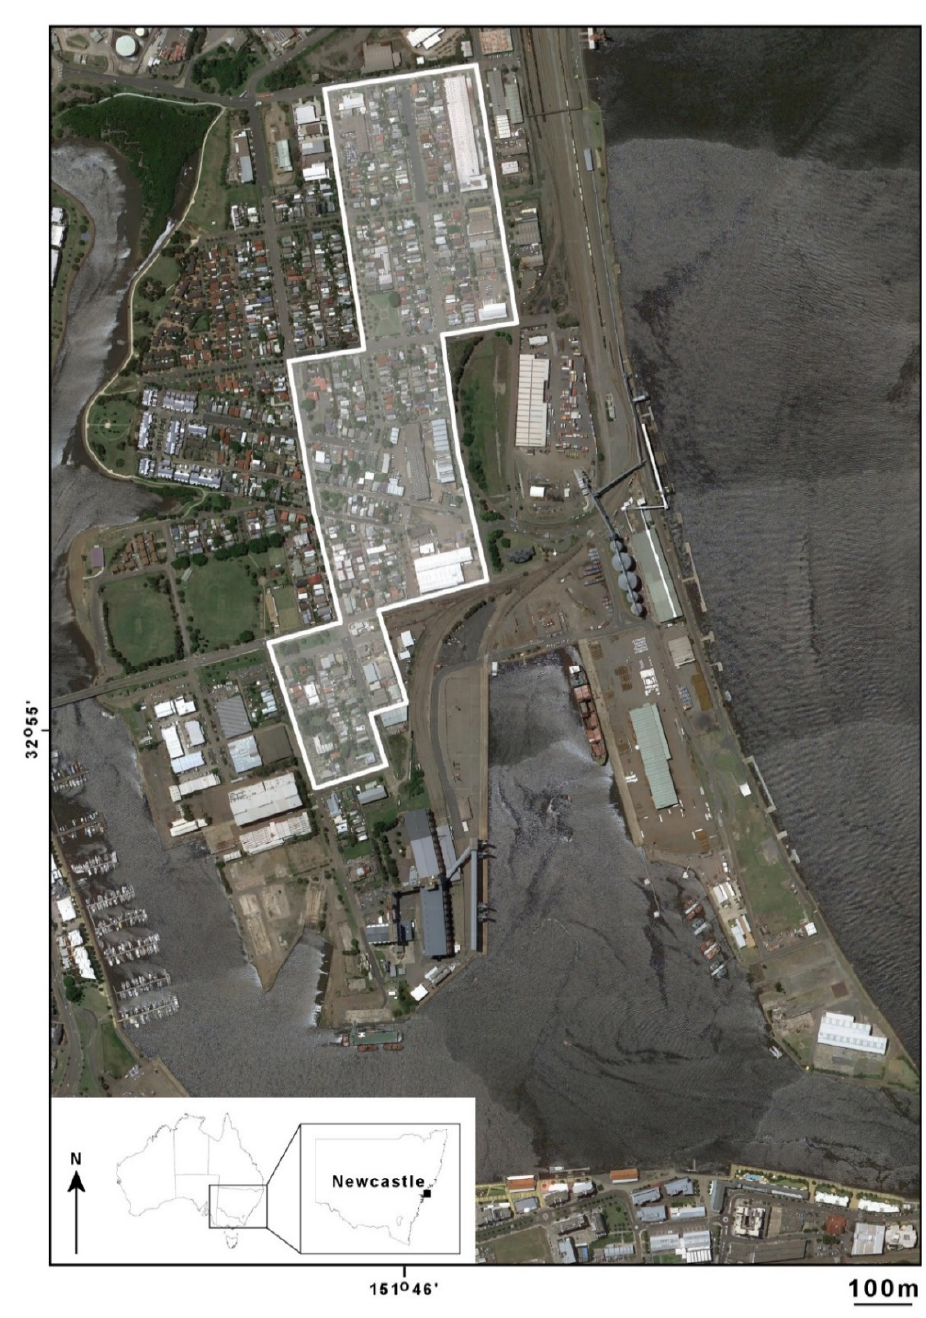
Figure 1. Residential and industrial areas where property surveys were conducted within the suburb of Carrington, adjacent to the Port of Newcastle, NSW, Australia. (Image: Google Earth; accessed 28 August